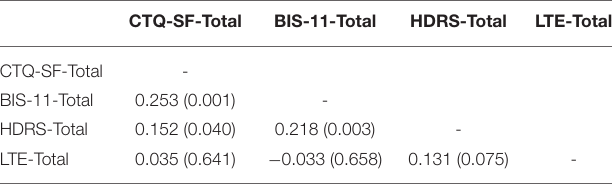
TABLE 2 | Partial correlations between traumatic events, impulsiveness, and depressive symptoms [r (p)], after controlling for covariates (age, sex, level of education, work status, and recurrence of depressive